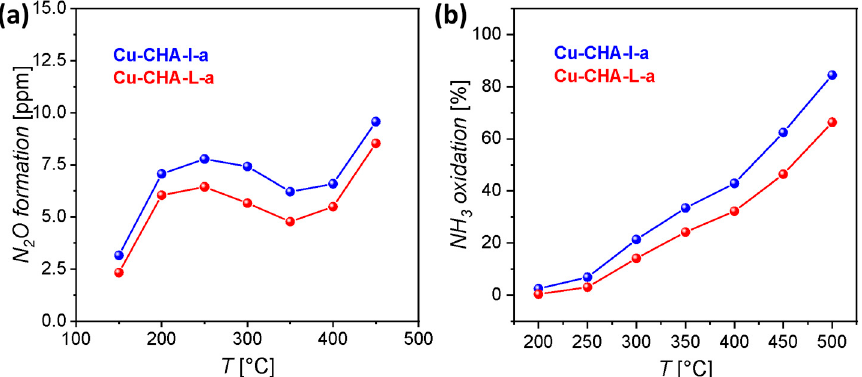
Figure 5. Investigation of SCR side reactions: N 2 O formation under ( a ) NH 3 -SCR conditions and ( b ) NH 3 oxidation in the absence of NO for Cu CHA I-a (blue) and Cu CHA-L-a